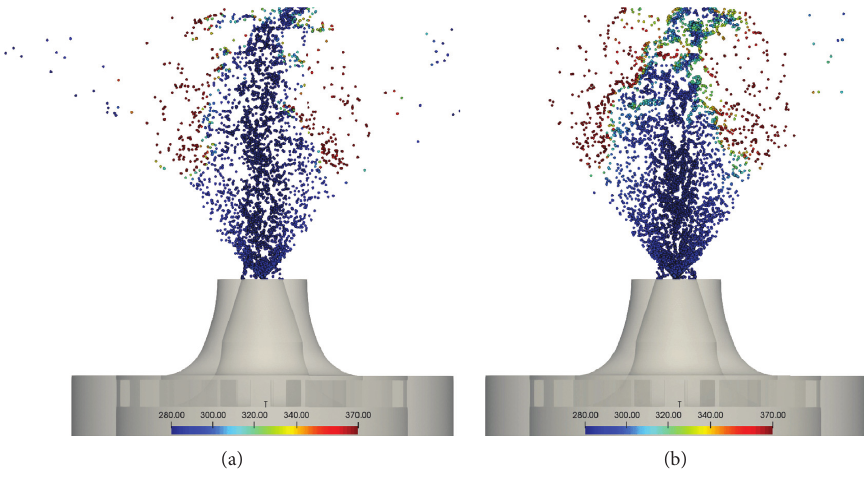
Figure 27: Droplet temperature for cases A-R (a) and B-R